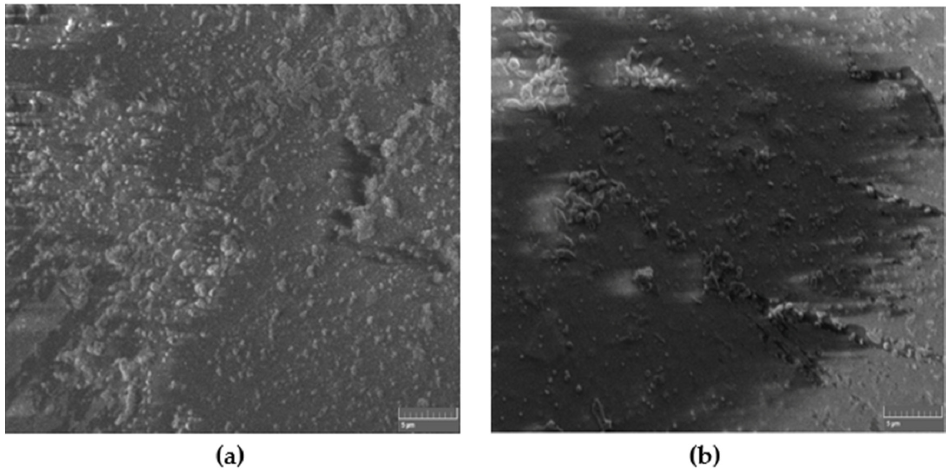
Figure 2. SEM images of non ‐ modified self ‐ cured composite for ( a ) hand and ( b ) ultrasonic mixing methods.